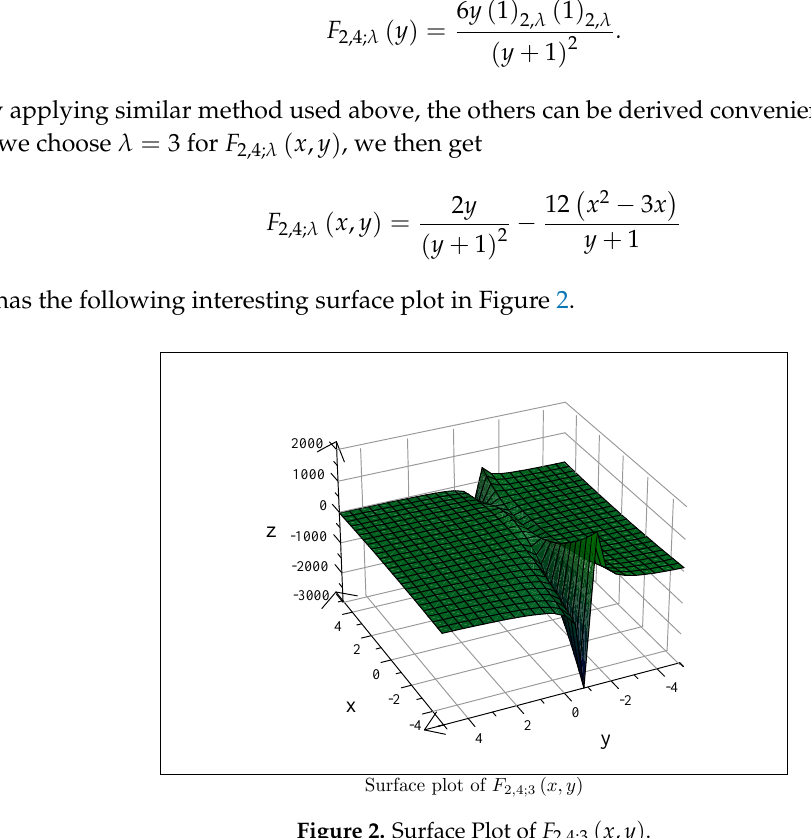
Figure 2. Surface Plot of F 2,4;3 ( x , y )